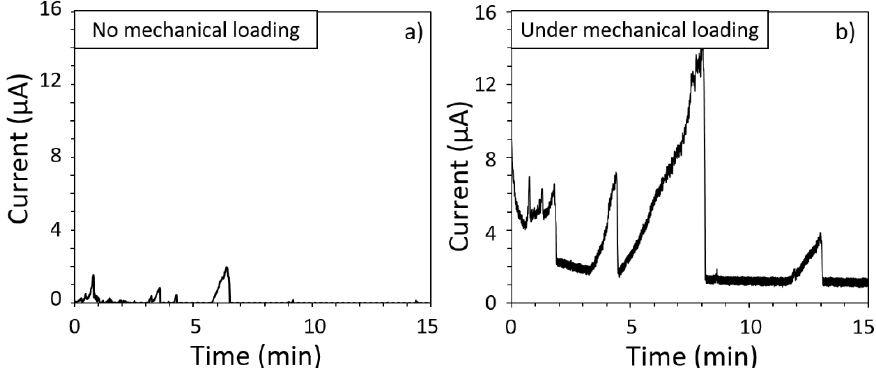
Figure 10. Current transients observed on samples exposed to 0.5 M NaCl solution: ( a ) Without mechanical loading; ( b ) with mechanical loading (EAC tests with an imposed strain corresponding to an initial stress of 80% of the YS 0 . 2 value). Results are given for the AM MSS samples.